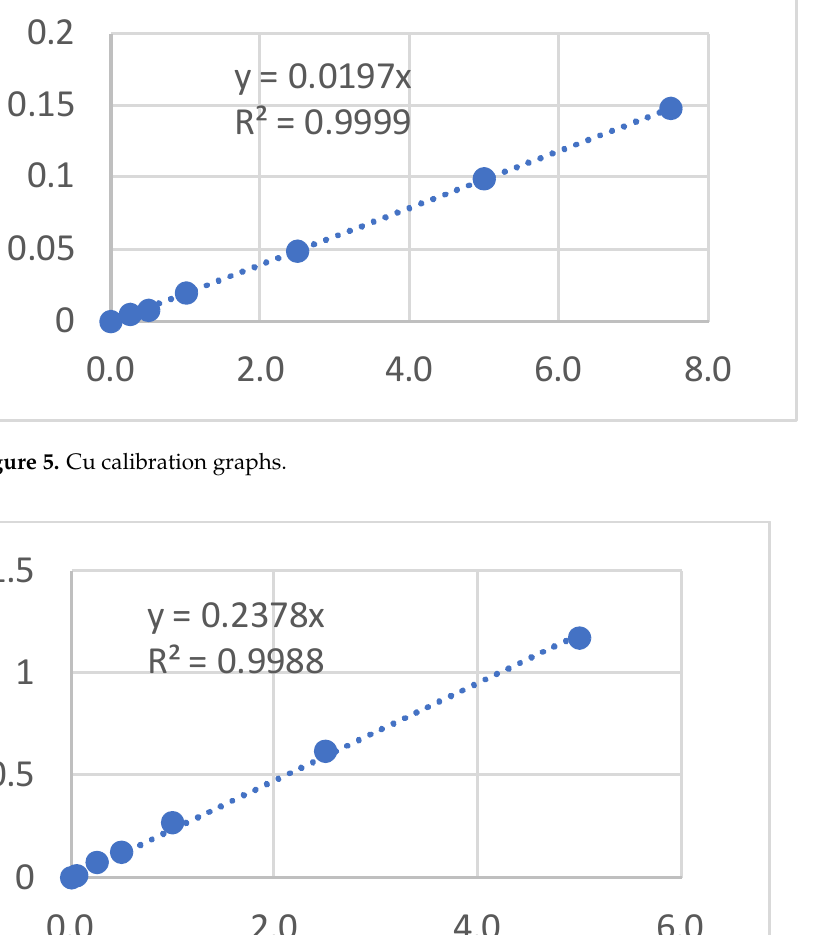
Figure 6. Cd calibration graphs. They illustrate calibration graphs for each